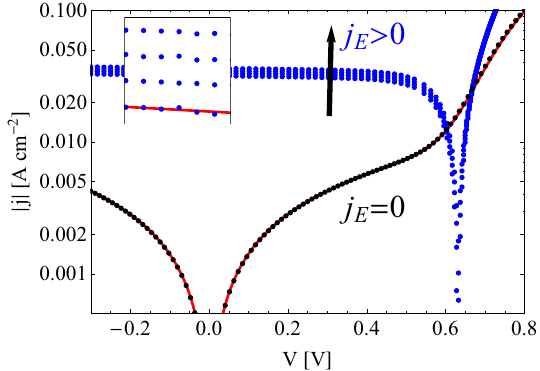
F. Obereigner and R. Scheer: Determining diode parameters of illuminated j - V curves